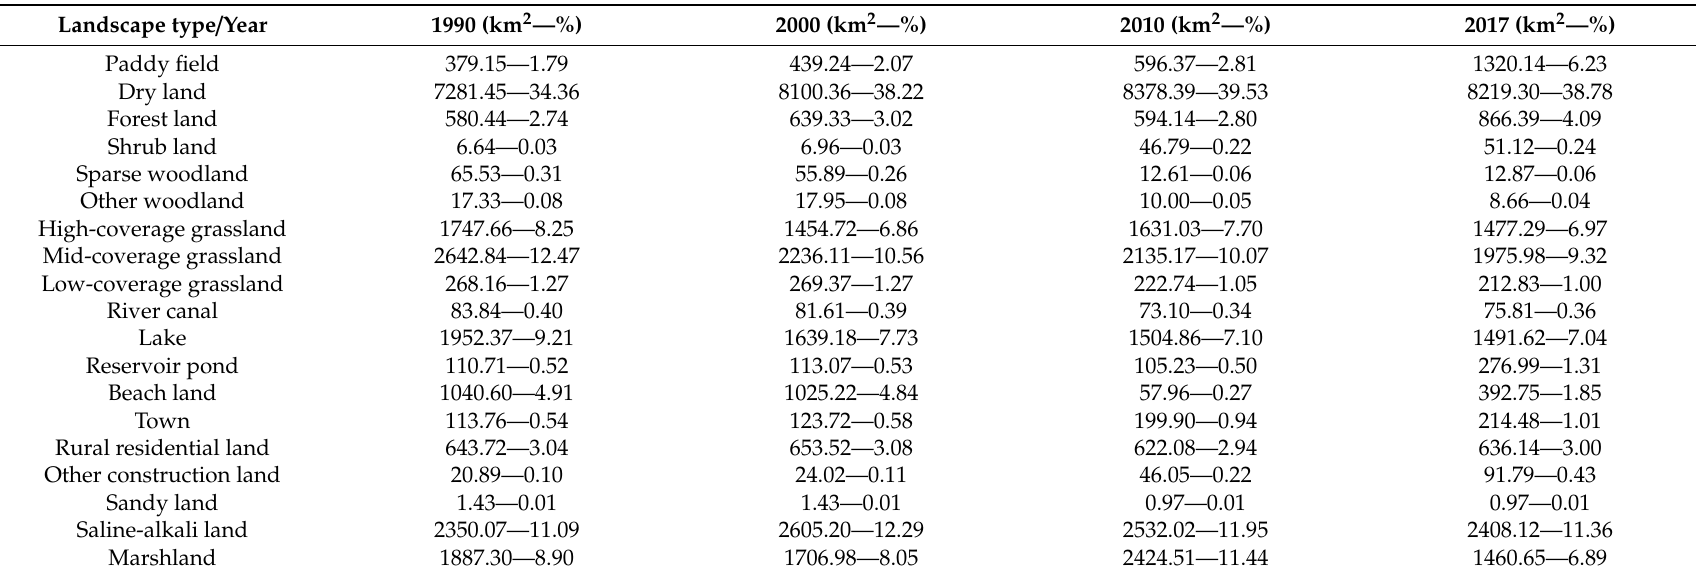
Table A2. Area and its percentage of di ff erent landscape types in Daqing for the period